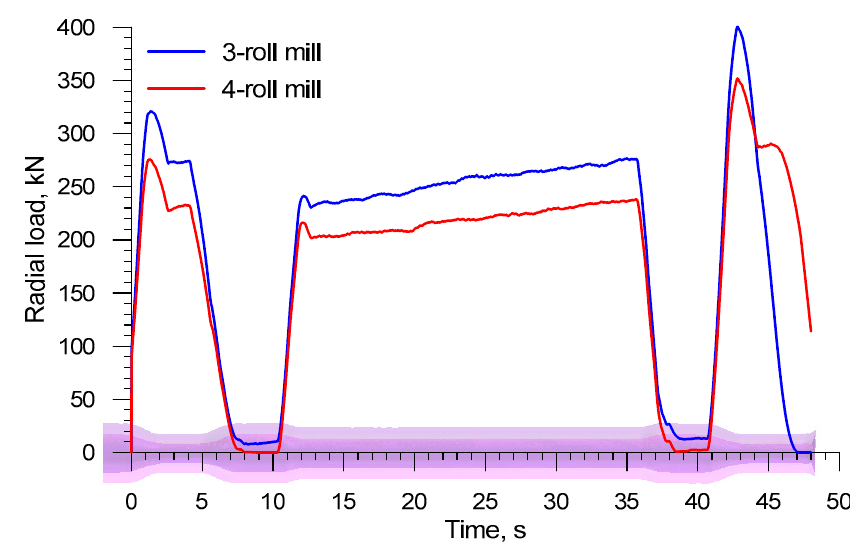
Figure 18. Radial load on the roll in skew rolling hollow axles in 3- and 4-roll mills.